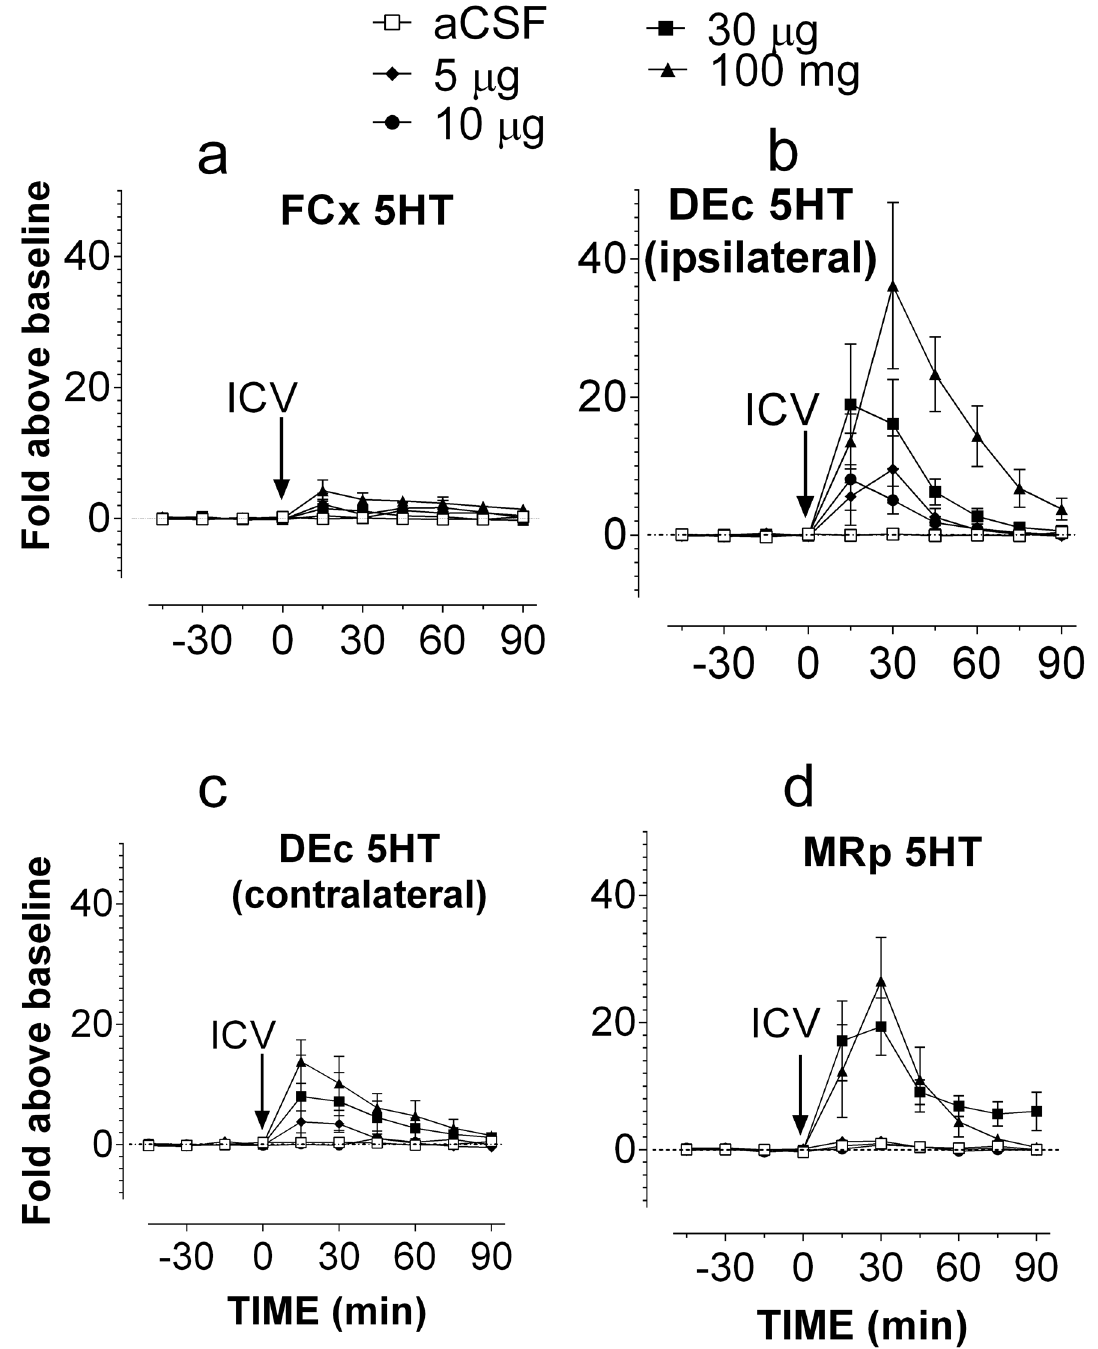
Fig 4. Relationship between intracranial injection of MDMA and occurrence of serotonin syndrome in male Sprague-Dawley rats. The route of intracranial administration was ICV. Serotonin syndrome was determined by measuring extracellular 5HT in the FCx, DEc and MRp. Arrows indicate the time of ICV administration at doses of 0 (aCSF; □ ), 5 μ g ( ◆ ), 10 μ g ( ● ), 30 μ g ( & ) or 100 μ g ( ▲ ). Data are expressed as mean ± s.e.m. a, FCx (n = 5 – 6 rats/group). b, Ipsilateral DEc (n = 4 – 6 rats/group). c, Contralateral DEc (n = 5 – 6 rats/group). d, MRp (n = 4 – 6 rats/group). For the purpose of clarification, symbols indicating statistical significance were omitted from the